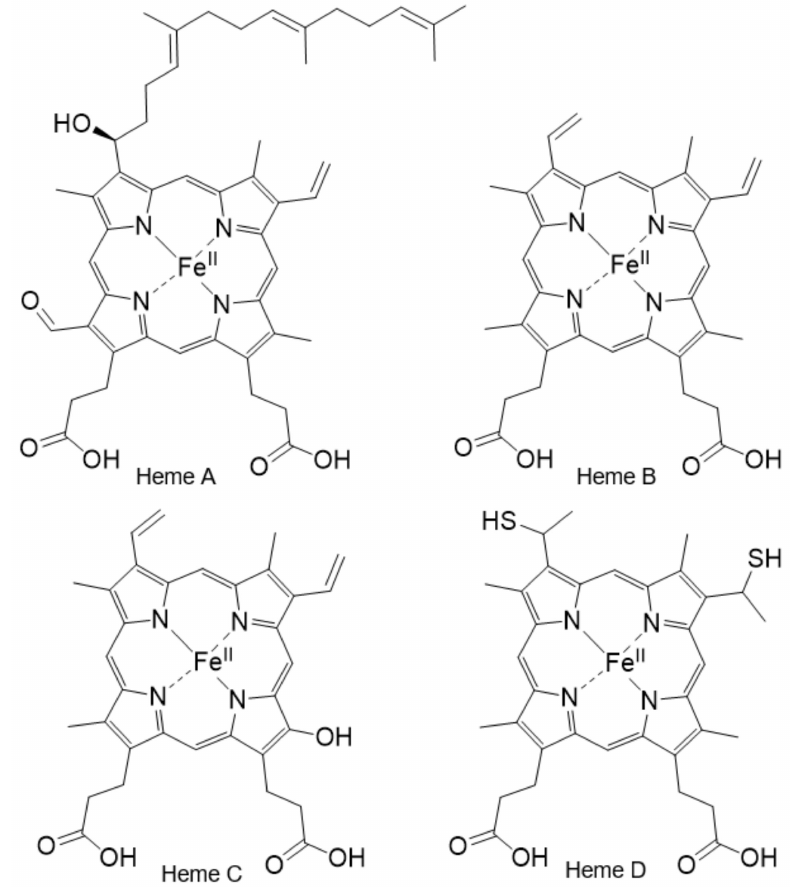
Figure 7. Structure of the heme